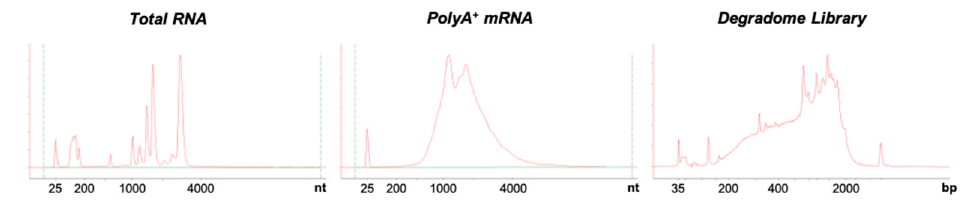
Figure 3 . 5 ′ P degradome library quality control. Bionalyzer profiles of total RNA, mRNAs after PolyA+ purification and after library construction.